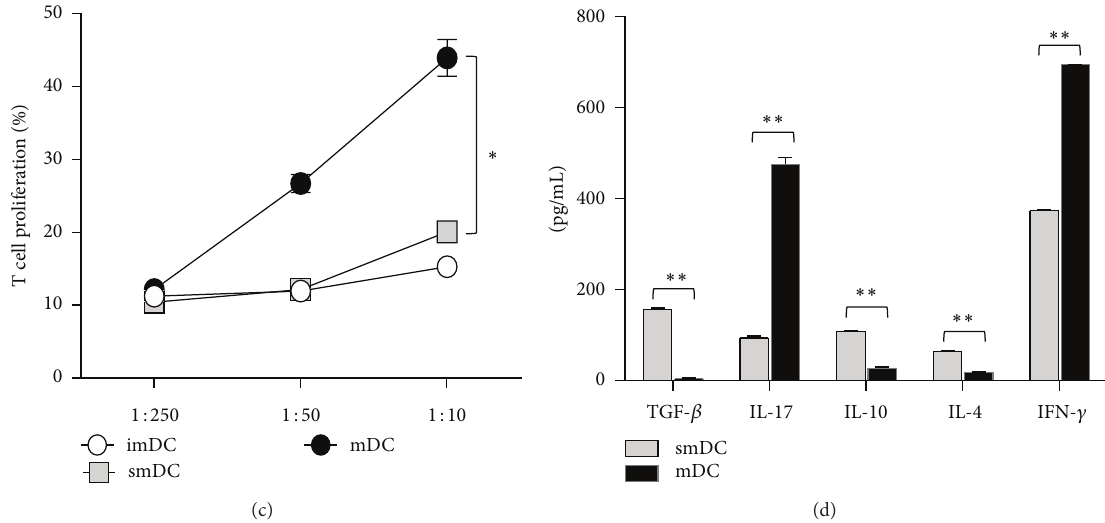
Figure 1: Surface phenotypes and characteristics of smDCs. (a) Representative FACS data showing the surface phenotype of bone marrow cell-derived imDCs, smDCs, and mDCs (upper), and geometric mean fluorescence intensities (gMFI) of each surface molecule are shown (lower). (b) The expression level of CCR7 on the surface of imDCs, smDCs, and mDCs was assessed by FACS after staining with anti-CCR7 mAb. CCR7 + cell populations in each representative FACS data are indicated (upper). The migration of imDCs, smDCs, and mDCs was assessed by an in vitro CCL19/MIP-3 𝛽 chemotaxis assay as described in Section 2. DCs were seeded in the upper chamber, and the number of migrated DCs was analyzed after 3h. (lower). (c) T cell stimulation capacity of each DC subset. Purified CFSE-labeled splenic T cells were mixed with each syngeneic imDCs, smDCs, and mDCs at different ratios for 5 days. (d) Cytokine production was determined in primary cultures at DC/T cell ratios of 1:10. The supernatants were collected for IFN- 𝛾 , IL-10, IL-17, IL-4, and TGF- 𝛽 production as determined by ELISA. The statistical data in (b) ∼ (d) are shown as mean ± SEM from more than 3 independent experiments. ∗ 𝑝 < 0.05 , ∗∗ 𝑝 < 0.01 , ∗∗∗ 𝑝 < 0.001 in Student’s 𝑡